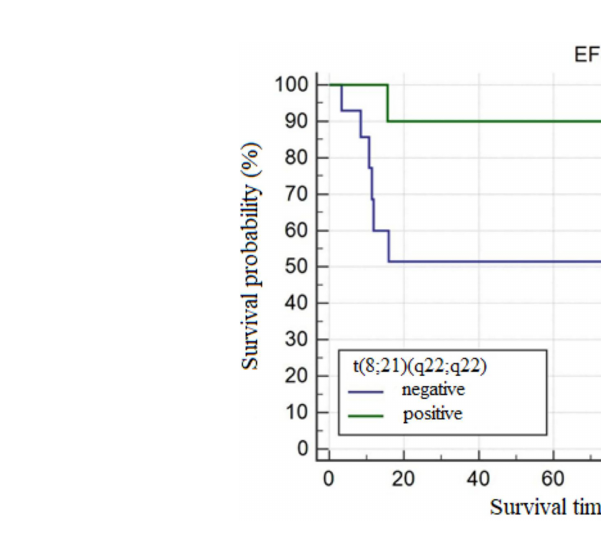
FIGURE 4 | The 5-year event-free survival probability (pEFS) in patients with and without t(8;21)(q22;q22),